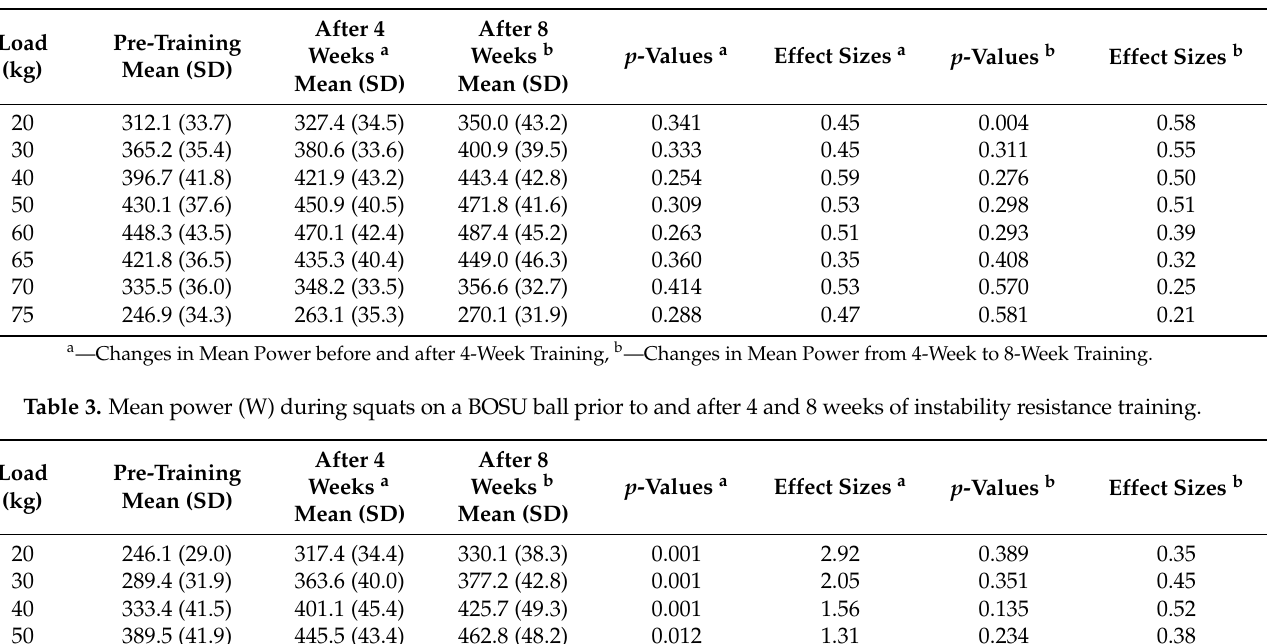
Table 2. Mean power (W) during bench presses prior to and after 4 and 8 weeks of instability resistance training.